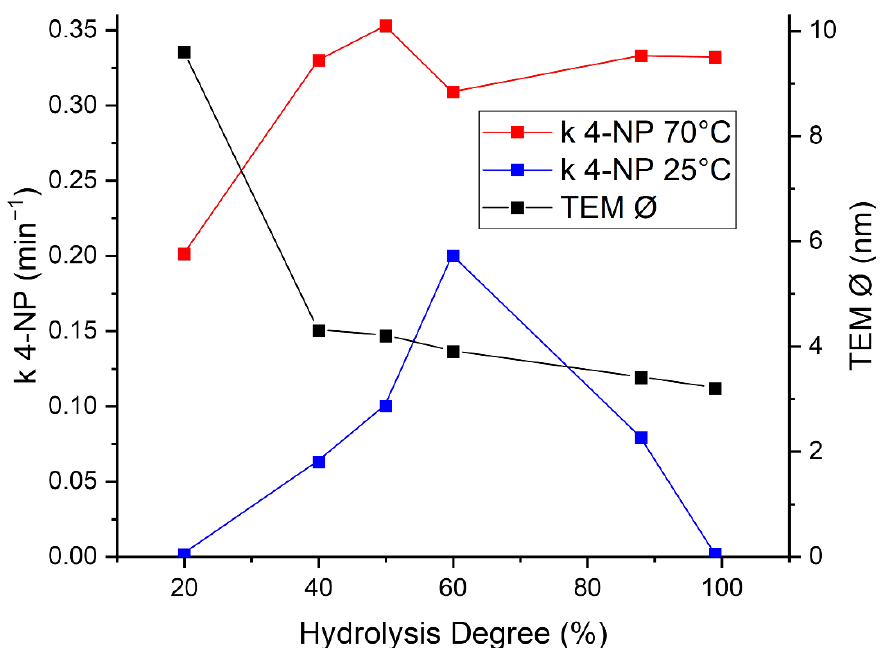
Figure 10. Effect of temperature on the catalytic performances in 4-NP reduction. Blue indicates the apparent kinetic constants at 25 °C; red indicates the apparent kinetic constants at 70 °C; black indicates the mean Au particle sizes measured with TEM analysis of the fresh catalysts.